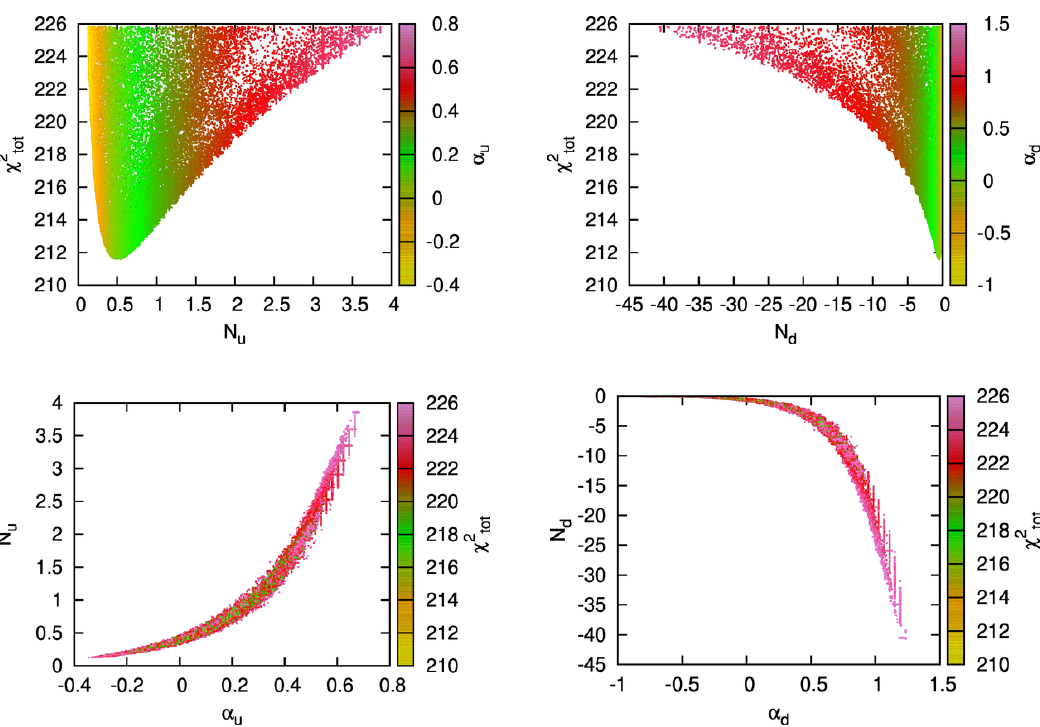
Figure 4 . Parameter space scatter plots for the (cid:11) -(cid:12)t, which includes the (cid:11) u and (cid:11) d free param- eters. The regions displayed correspond to our estimate of 2 (cid:27) C.L. error band. Notice that the uncertainties on the parameters which can be inferred from the scatter plots are much larger than the errors reported in table